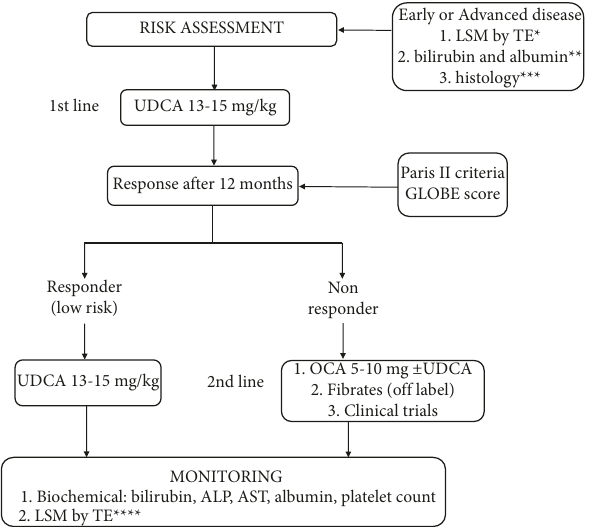
Figure 1: Risk assessment, treatment, and monitoring for PBC patients. ∗ early from advanced disease stage based on LSM by TE (LSM < 10kPa or LSM > 10kPa). ∗∗ both parameters normal vs. at least 1 parameter abnormal. ∗∗∗ absent or mild fibrosis vs. bridging fibrosis or cirrhosis. ∗∗∗∗ repeat TE every 2 years in early stage and every year for advanced